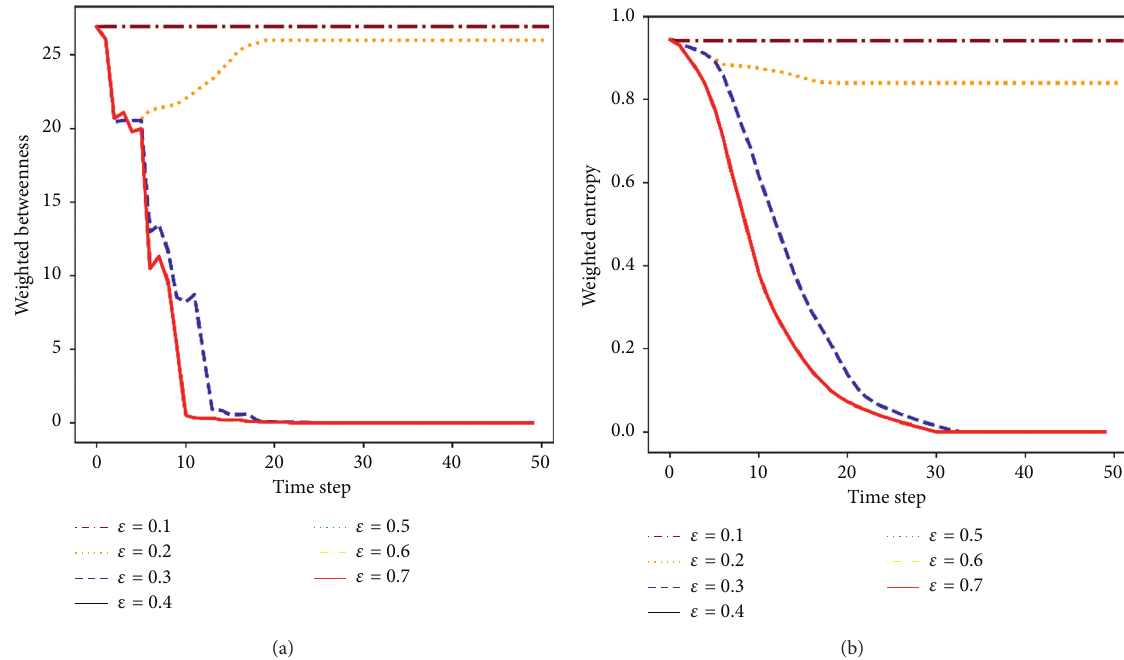
Figure 8: Changes of passenger-flow-weighted network reliability during cascading failure caused by the Pu-Dong Avenue Station under different ε values (a) for weighted betweenness and (b) for weighted